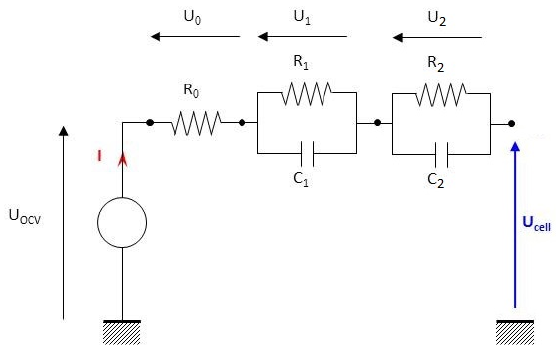
Figure 7. Diagram of the 2nd-order battery electrical model.